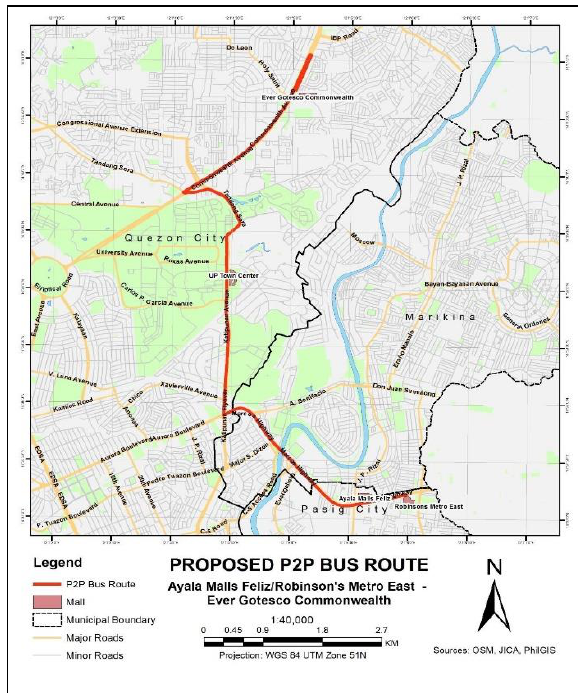
Figure 12. Sample Proposed P2P Bus Route 1 Map